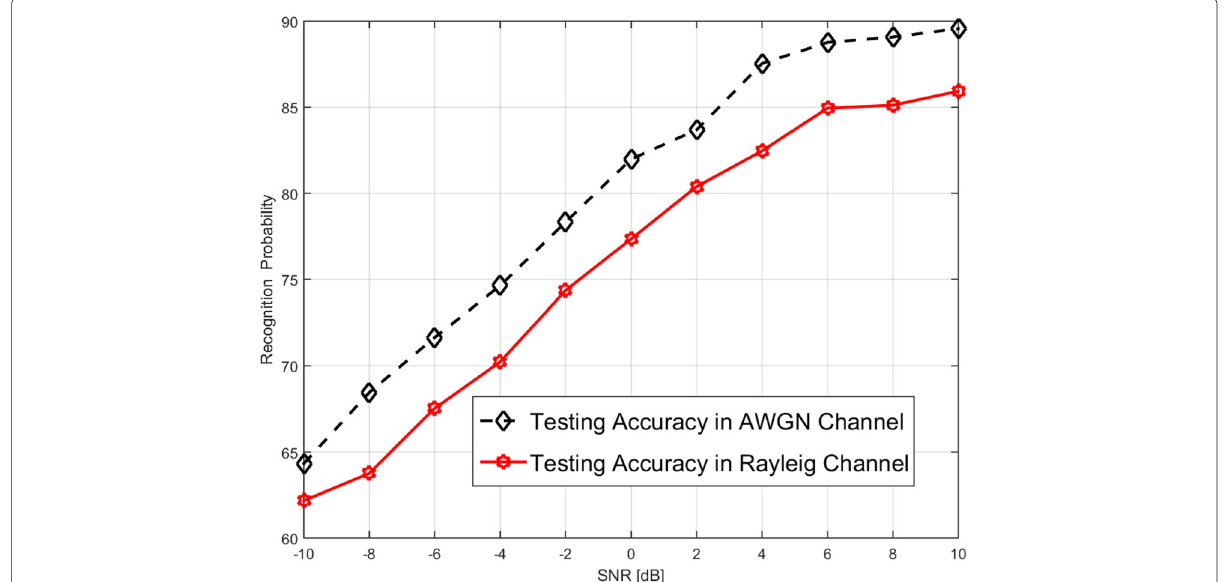
Fig. 4 φ 3 in the AWGN and Rayleigh fading